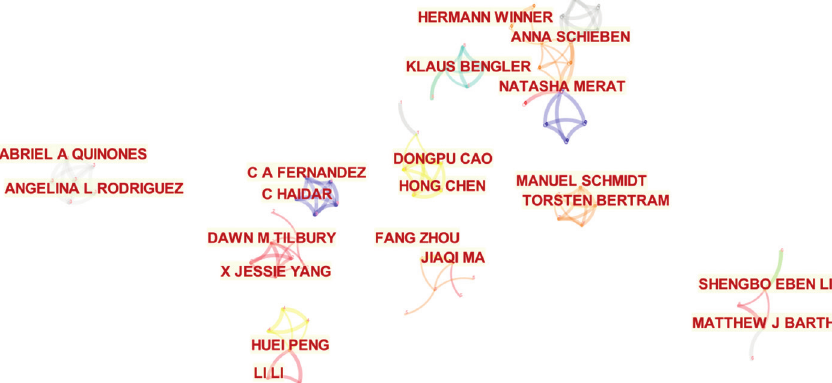
Figure 7: Literature co-citation network.